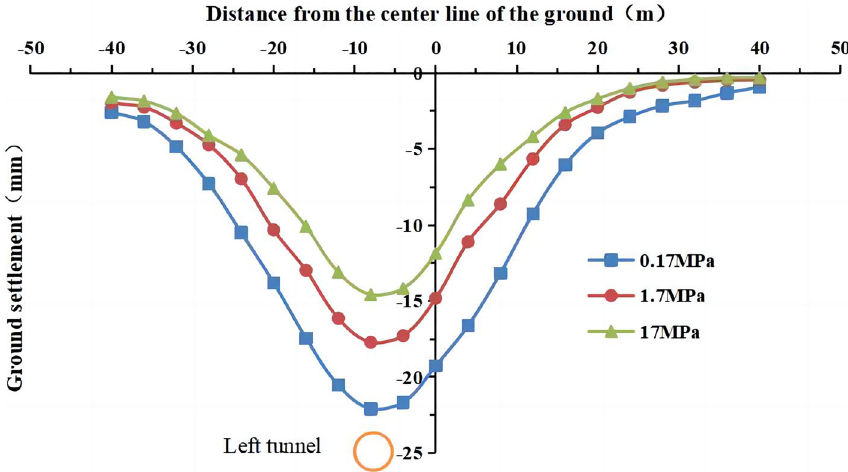
Figure 30. Surface settlement during single-line excavation for different deformation modulus values of the grouting